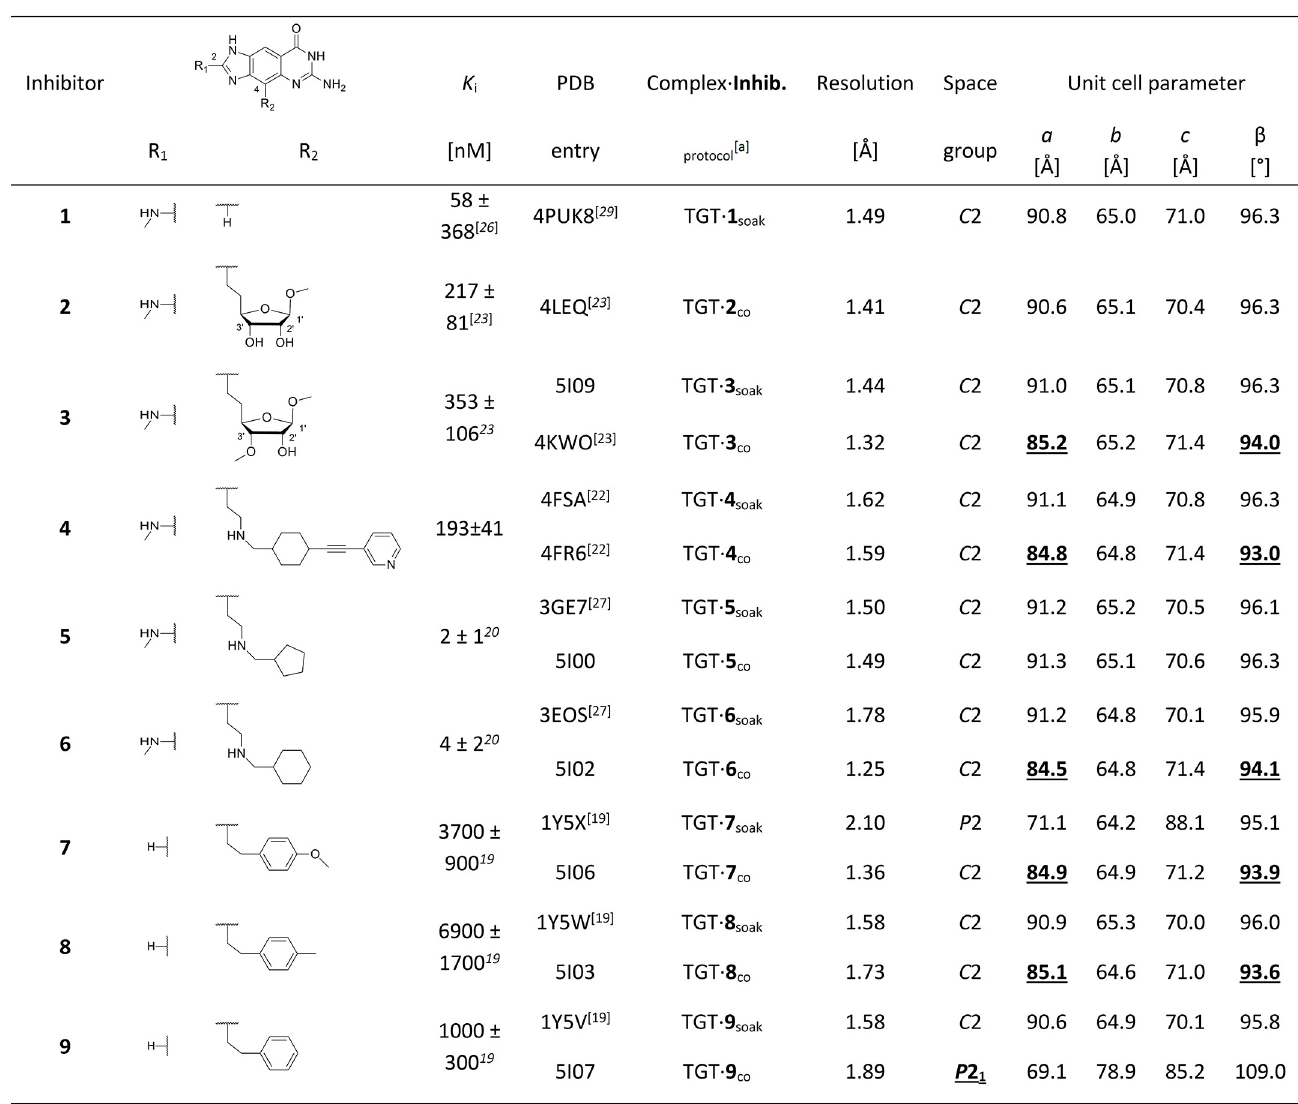
Fig 2. Overview of studied TGT inhibitors, inhibition constants (K i ), and crystalstructures.